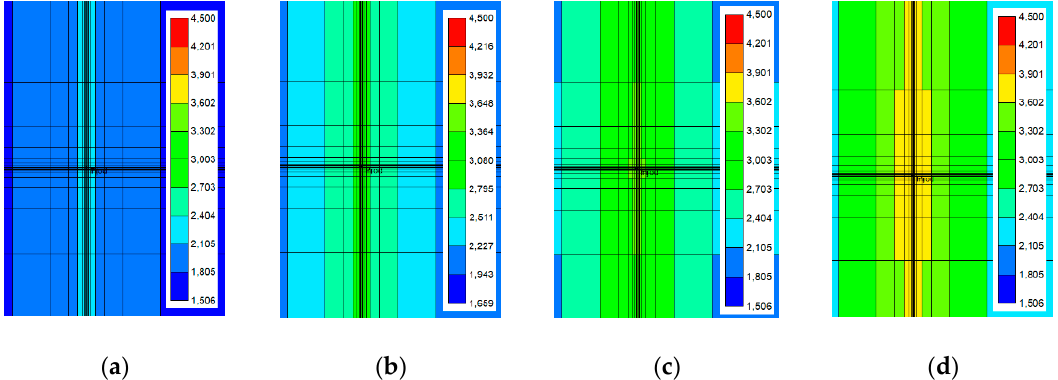
Figure 14. Pressure distribution for different injection pressure. ( a ) Injection pressure: 2500 psi; ( b ) Injection pressure: 3000 psi; ( c ) Injection pressure: 3500 psi; ( d ) Injection pressure: 4000 psi.